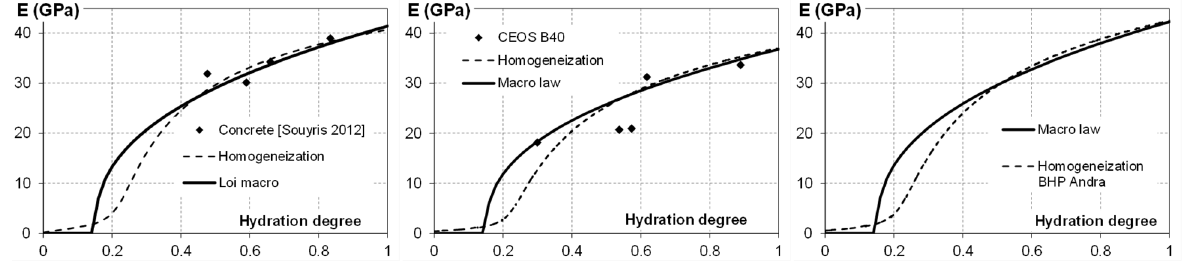
Figure 6. Identification of a macroscopic law for Young’s modulus on the results issued given by homogenization technique (dotted curve)(Measurements from [28,